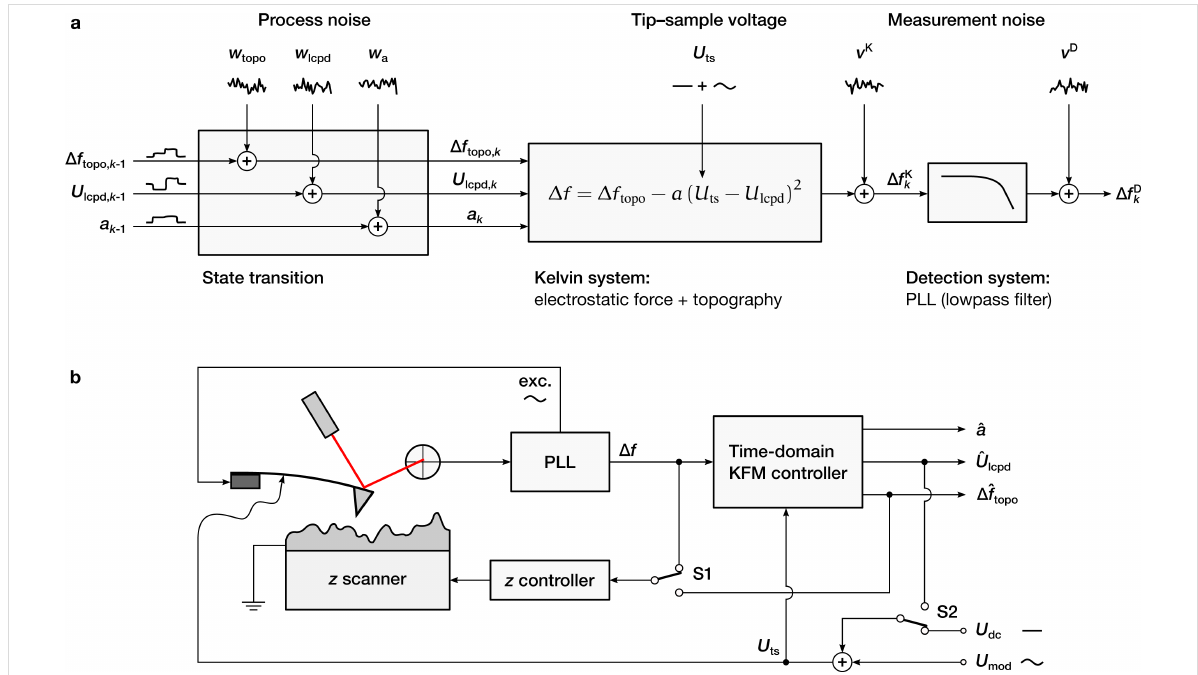
Figure 2: Design and operation of the time-domain KFM controller. (a) Underlying system model. (b) Measurement setup. The estimated topography- induced frequency shift, , can be used in place of Δ f to minimize electrostatic height errors (switch S1). The electrostatic force gradient between tip and sample is minimized by adding as a dc bias to U ts (switch